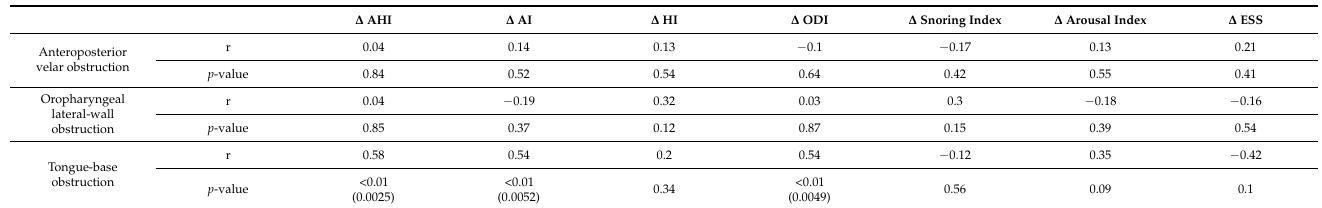
Table 4. Spearman’s rho (r) correlation coefficients for DISE findings with various differences ( ∆ ) in pre- to postoperative PSG metrics and